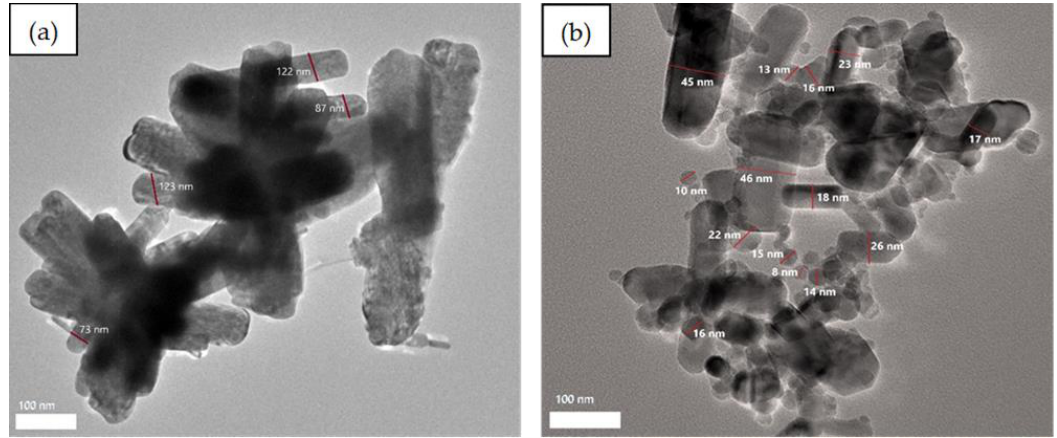
Figure 6. TEM images of synthesized ZnO NPs: ( a ) heated (60 °C) and ( b ) non-heated (28 °C).